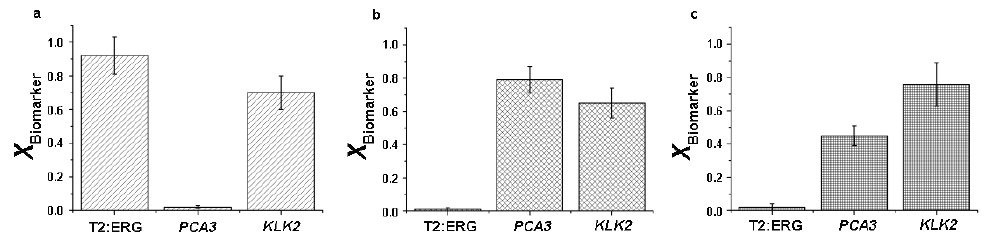
Figure 2. Detection of multiple ctRNA biomarkers in ( a ) DuCap, ( b ) LnCap, ( c ) 22Rv1 cell lines. Error bars represent standard deviations of three technical replicates.